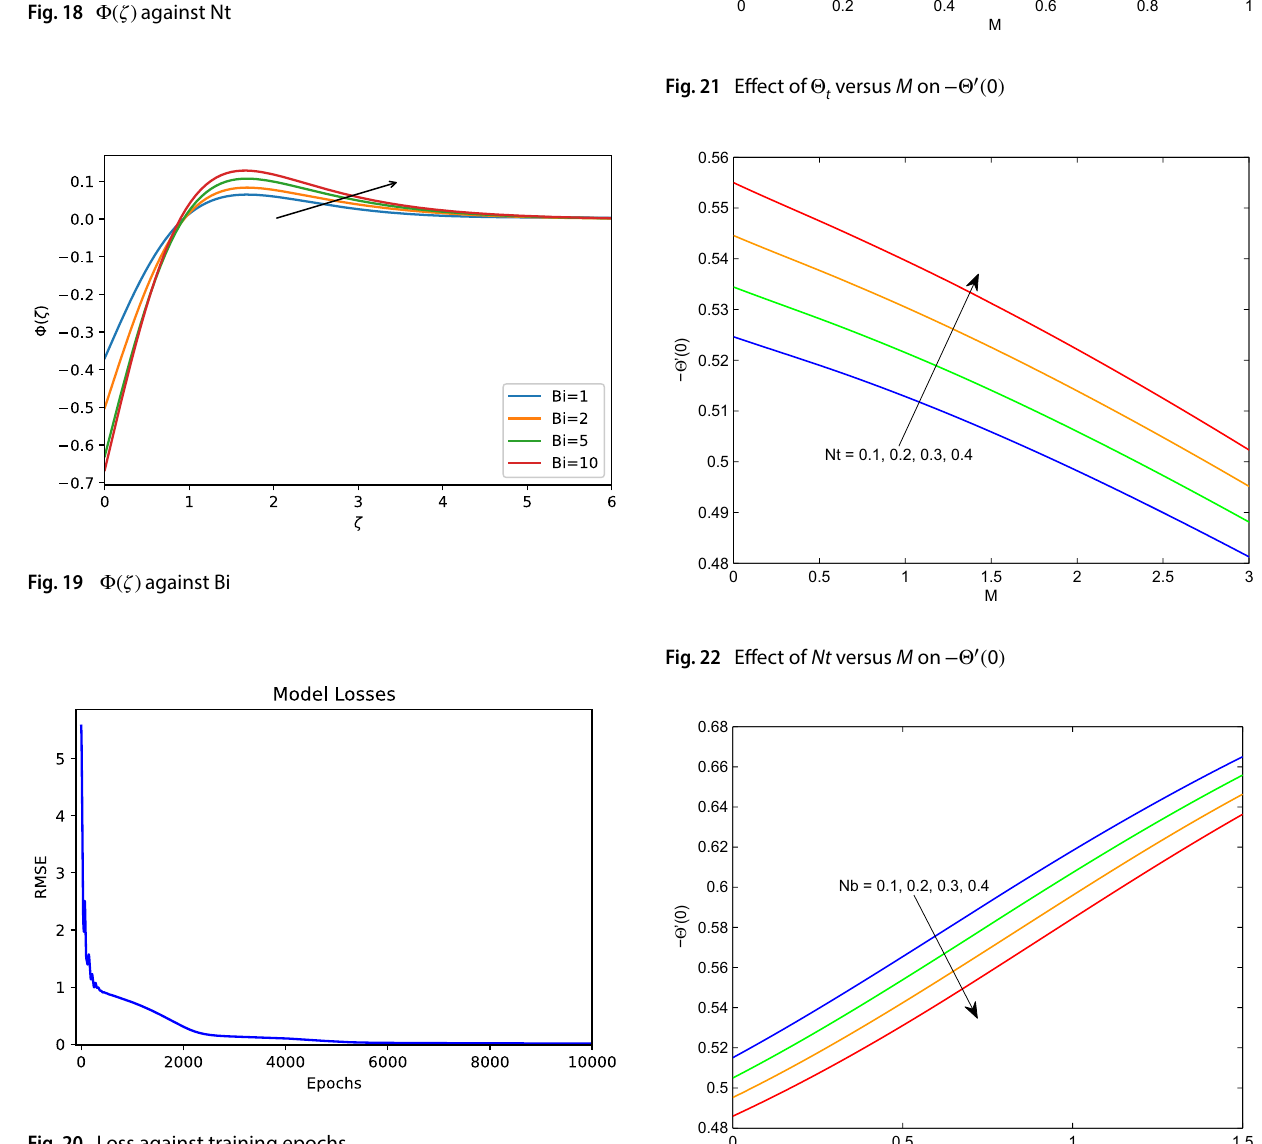
Fig. 20 Loss against training epochs